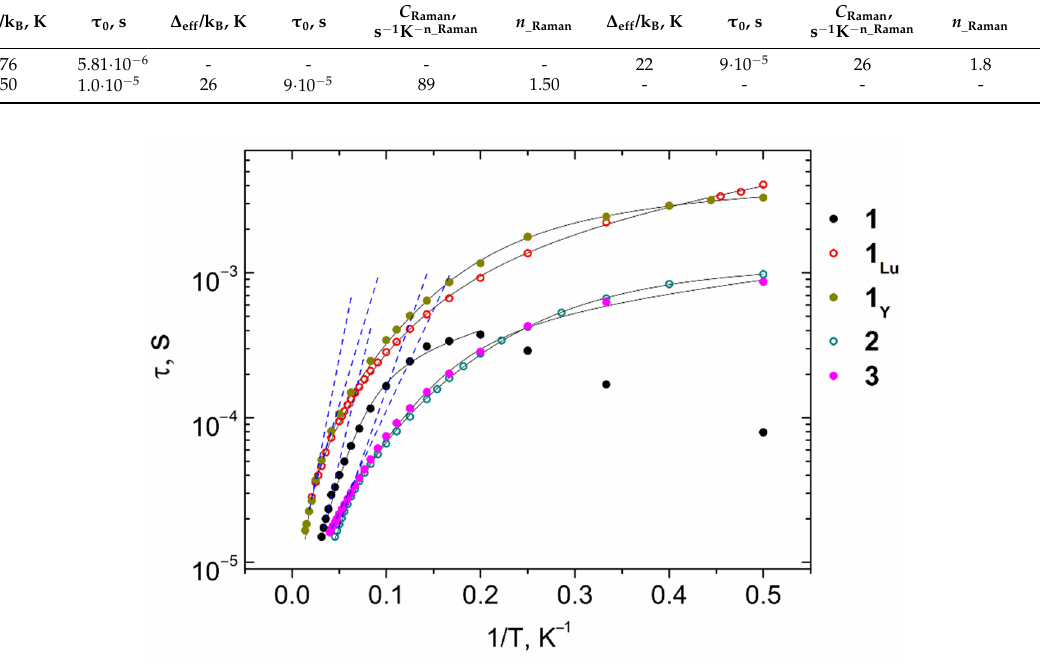
Figure 12. τ vs. 1/T dependences for complexes 1 – 3, 1 Y , and 1 Lu under H dc fields of 2500 ( 2, 3 , 1 Lu ) and 5000 Oe ( 1 , 1 Y ). Blue dashed lines represent fittings of the high-temperature range by the Orbach mechanism. Black solid lines represent fittings by the combinations of relaxation mechanisms presented in Tables 3 and 4.